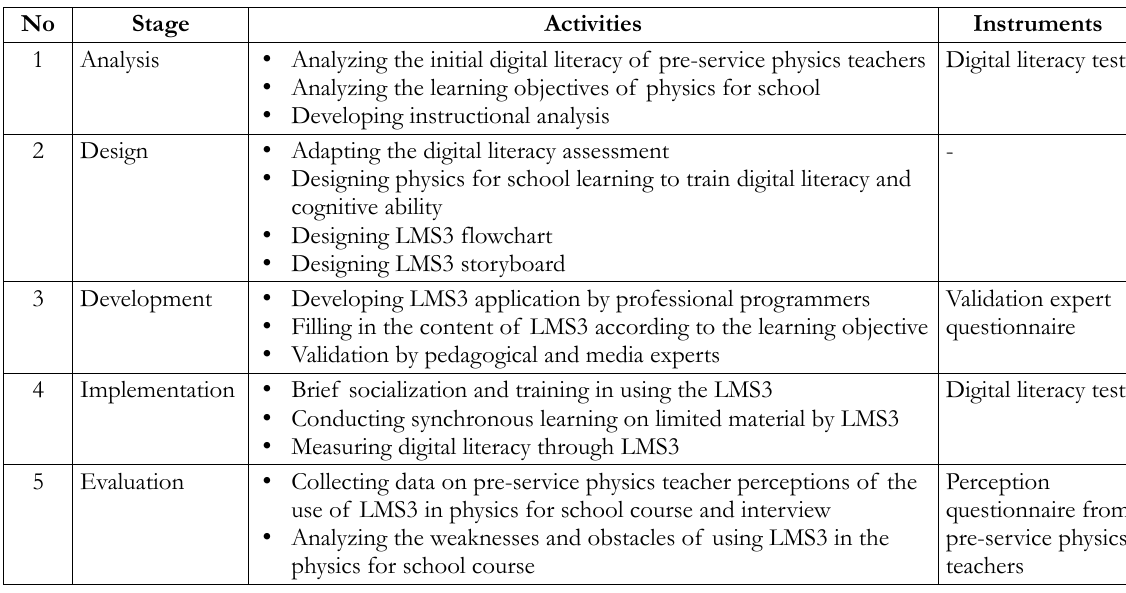
Table 1. The ADDIE Activities and Instruments in Developing